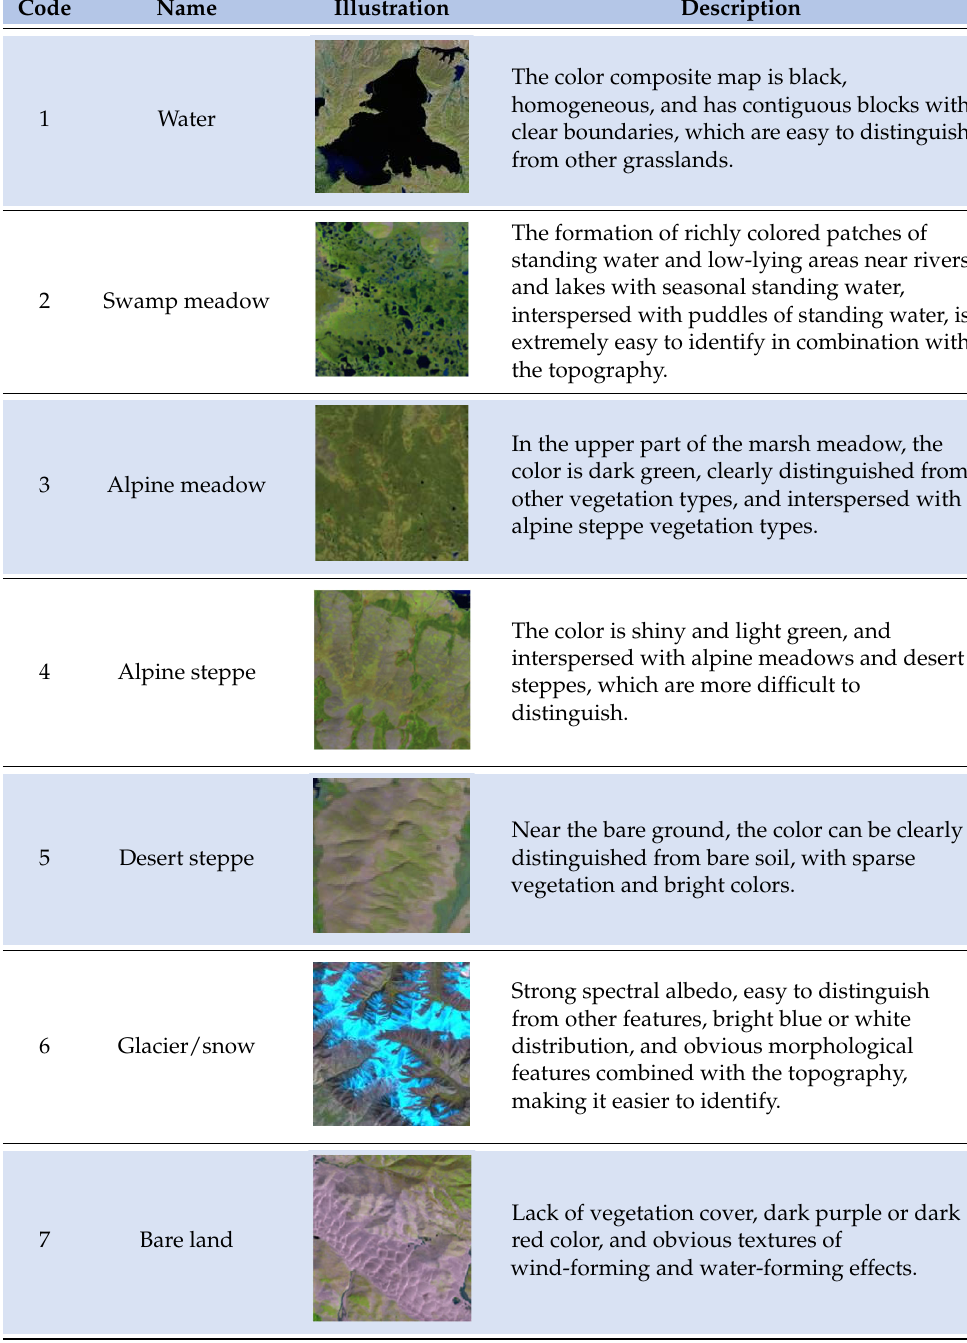
Table 2. Vegetation classification system and field characteristics of Sanjiangyuan National Park.